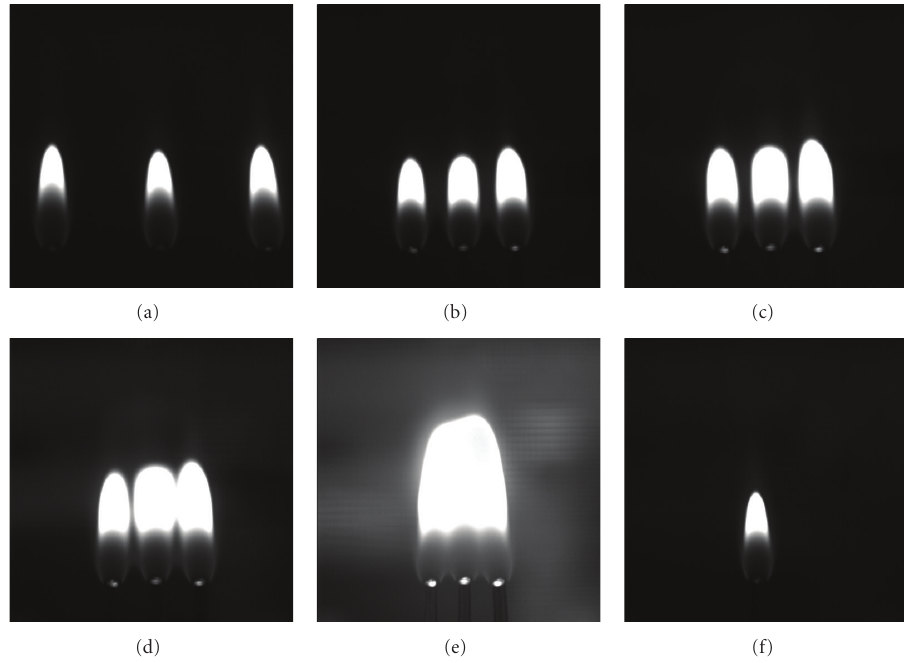
Figure 16: Interaction stages with Re i = 3 . 70. (a) Spacing = 32 d i (1in), isolated flame, (b) spacing = 16 d i (0.5in), individual flame with weak interaction; (c) spacing = 14 . 4 d i (0.45in), individual flame with stronger interaction; (d) spacing = 13 . 12 d i (0.41in), incipient group flame; (e) spacing = 9 . 92 d i (0.31in), sheath flame, and (f) individual flame with Re i = 1 .